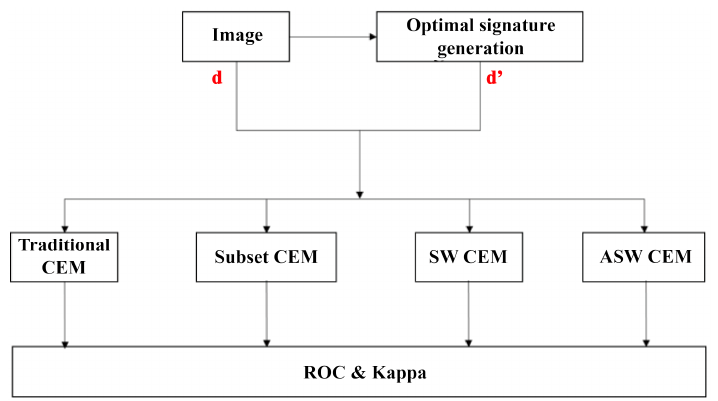
Figure 9. Flowchart of all algorithms for this experiment.